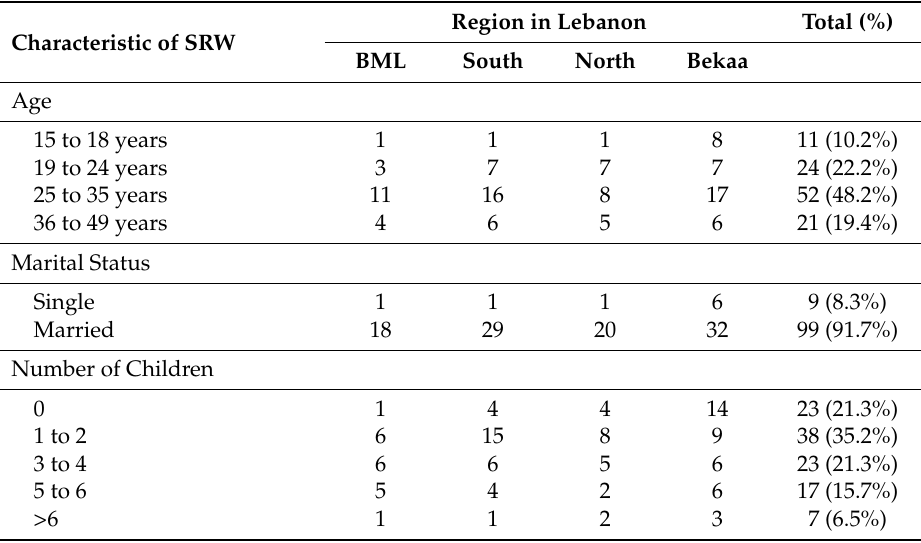
Table 2. Characteristics of interviewed Syrian refugee women in four governorates in Lebanon.